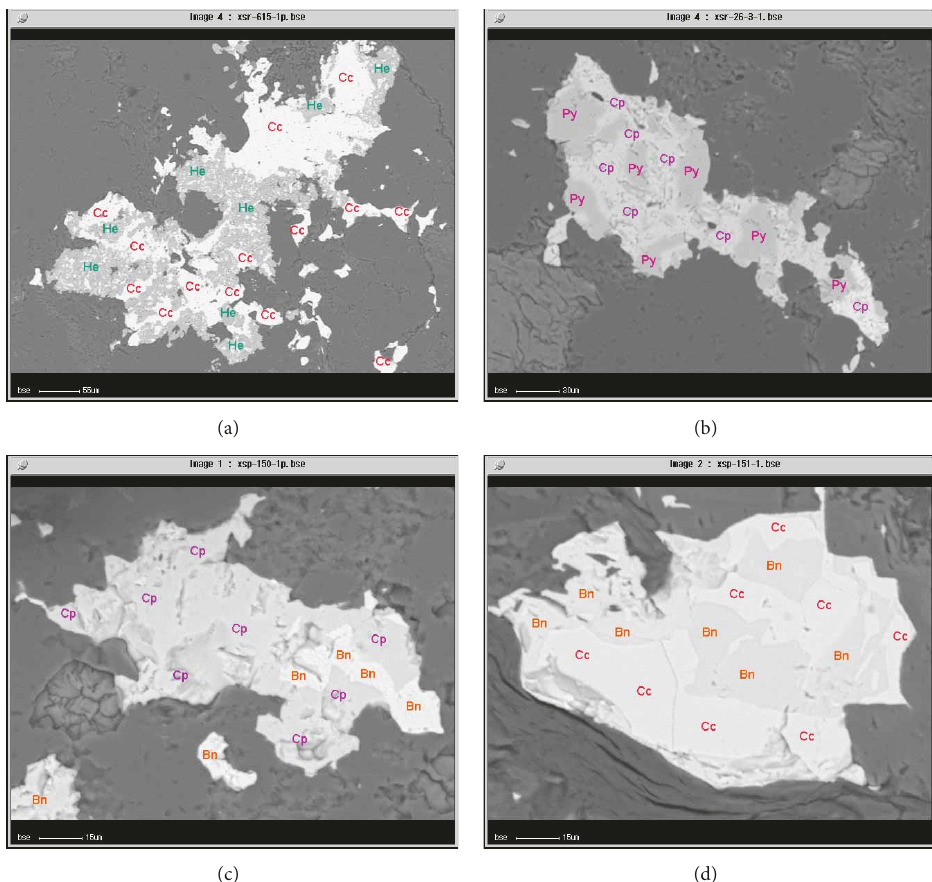
Figure5:ThetextureandmineralcompositionoforeintheDayaocopperdeposit.(a)Chalcocite(Cc)replacementbyhematite(He)(XSR615- 1); (b) pyrite (Py) replacement by chalcopyrite (Cp) (XSR-26-3-1); (c) chalcopyrite (Cp) replacement by bornite (Bn) (XSR-150-1); and (d) bornite (Bn) replacement by chalcocite (Cc) (XSR-151-1). The sample location is ZK15602 (XSR-615-1) and ZK1503-1 (XSR-26-3-1, XSR-150-1, and XSR-151-1) (see Figures 2(b) and